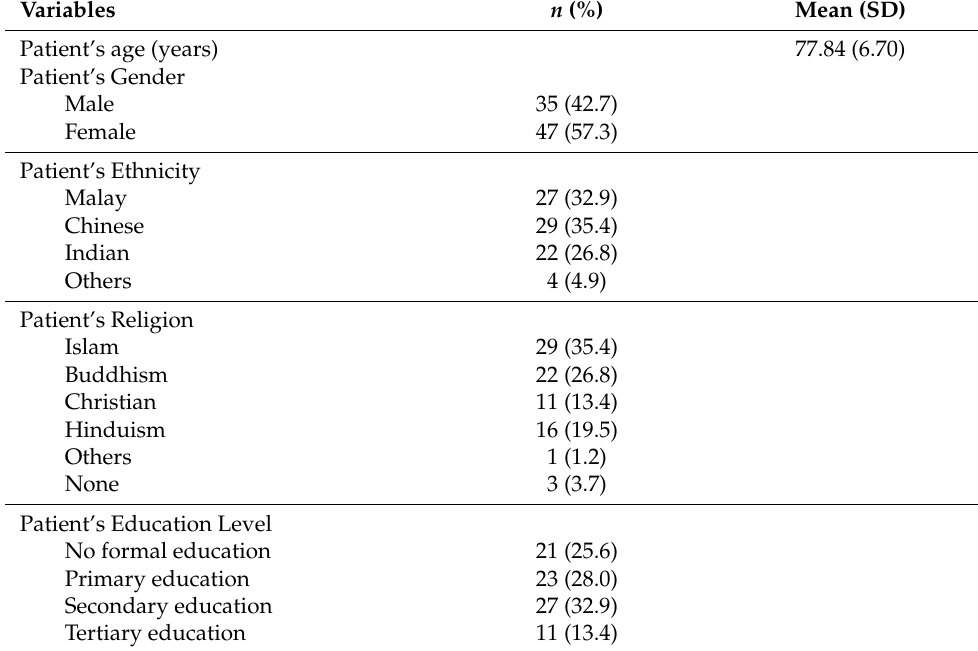
Table 1. Sociodemographics of